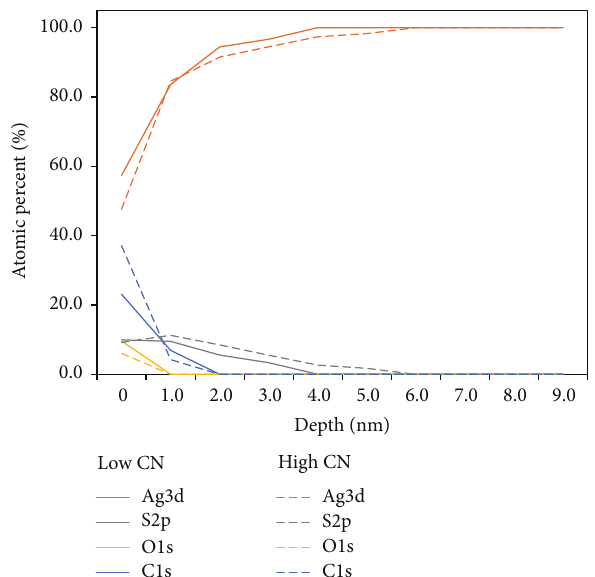
Figure9:CompositionalprofileofAgfilmspreparedbylowcyanide and high cyanide systems as a function of etched